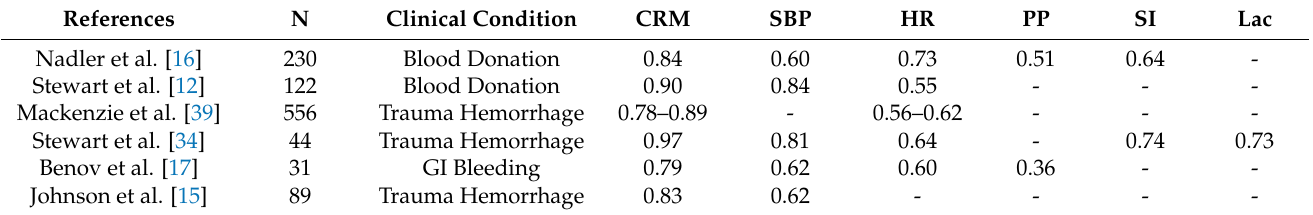
Table 2. Receiver-Operating Characteristic (ROC) Area Under the Curve (AUC) values for CRM com- pared to various standard vital signs used for assessing the clinical status of bleeding trauma